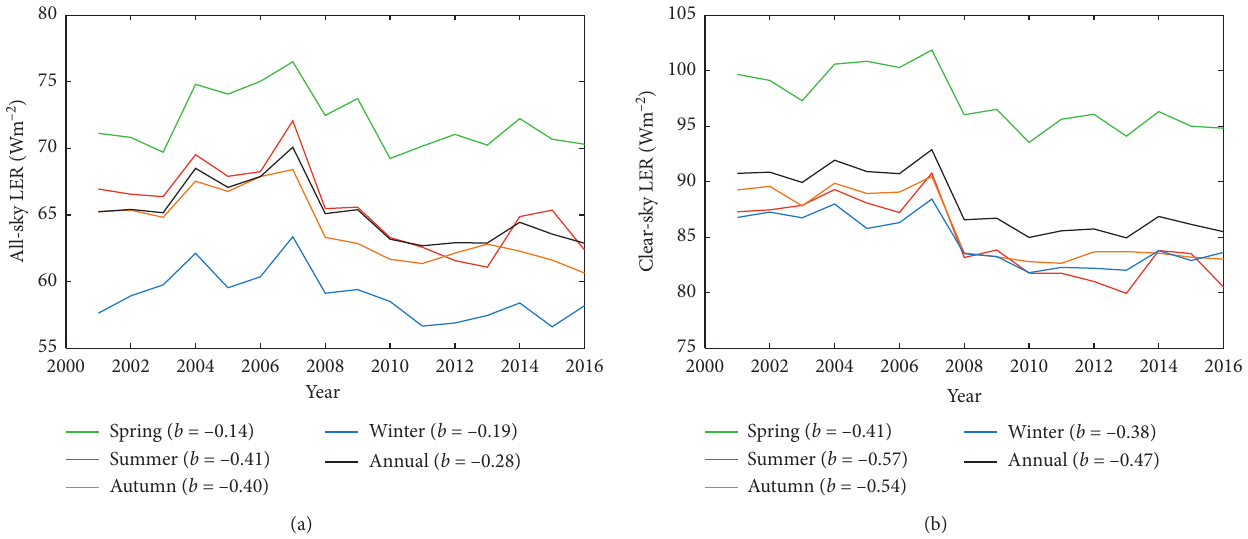
Figure 5: Time series of annual and seasonal LER (Wm − 2 ) in China for (a) all-sky conditions and (b) clear-sky conditions during the period